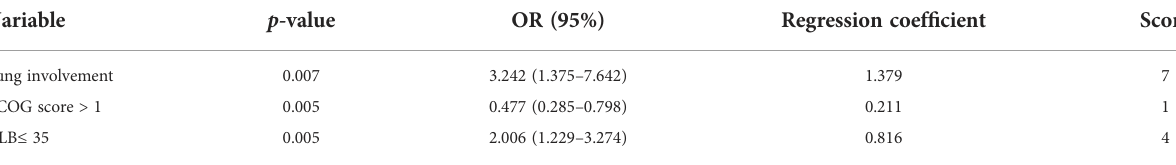
TABLE 4 Prediction model for